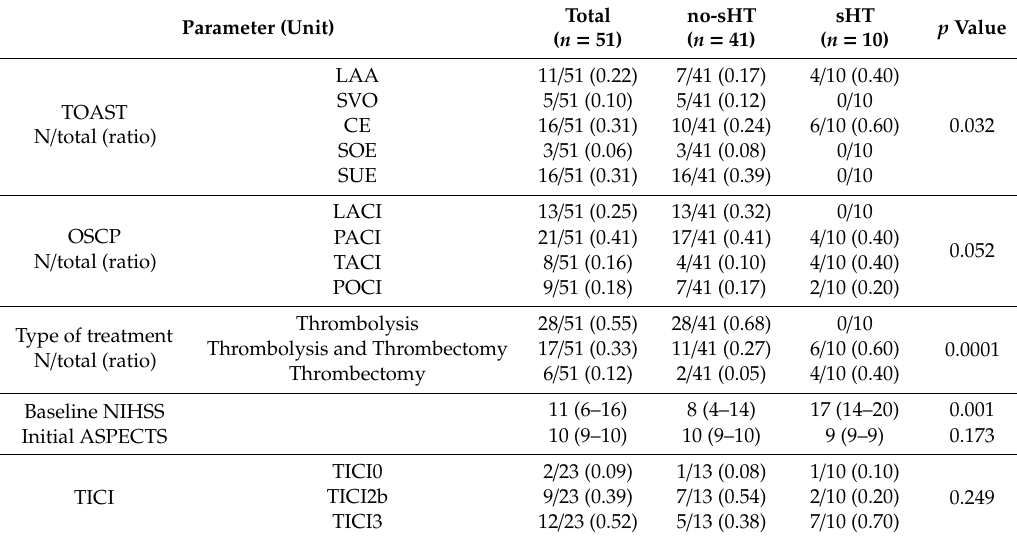
Table 2. Stroke characteristics according to Symptomatic hemorrhagic transformation (sHT).